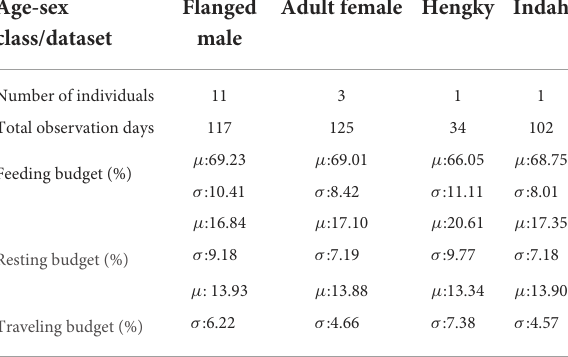
TABLE 2 Description of observational data which served as a criterion for the calibration process evaluating the model